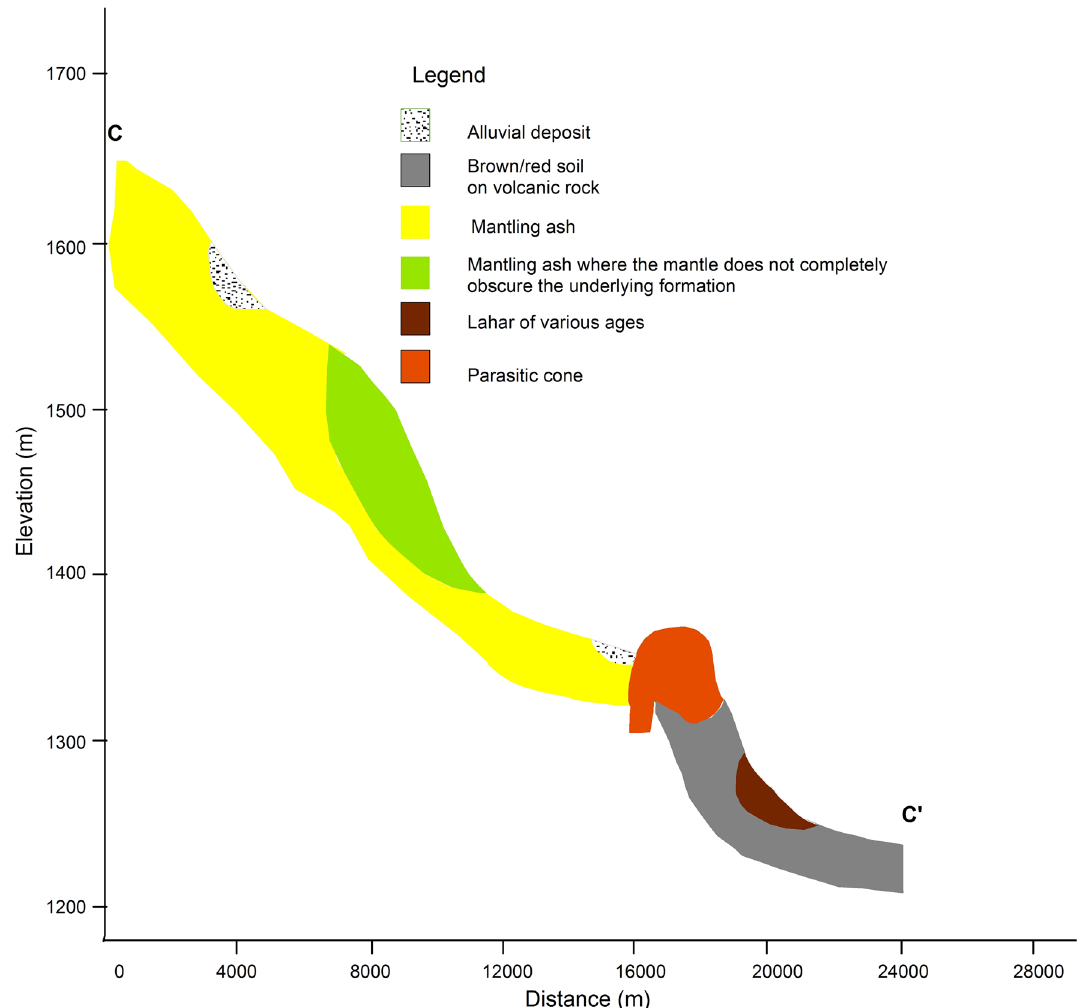
Fig. 3 Geological cross section C–C ′ from the steep slopes of Mt. Meru toward the foot of the